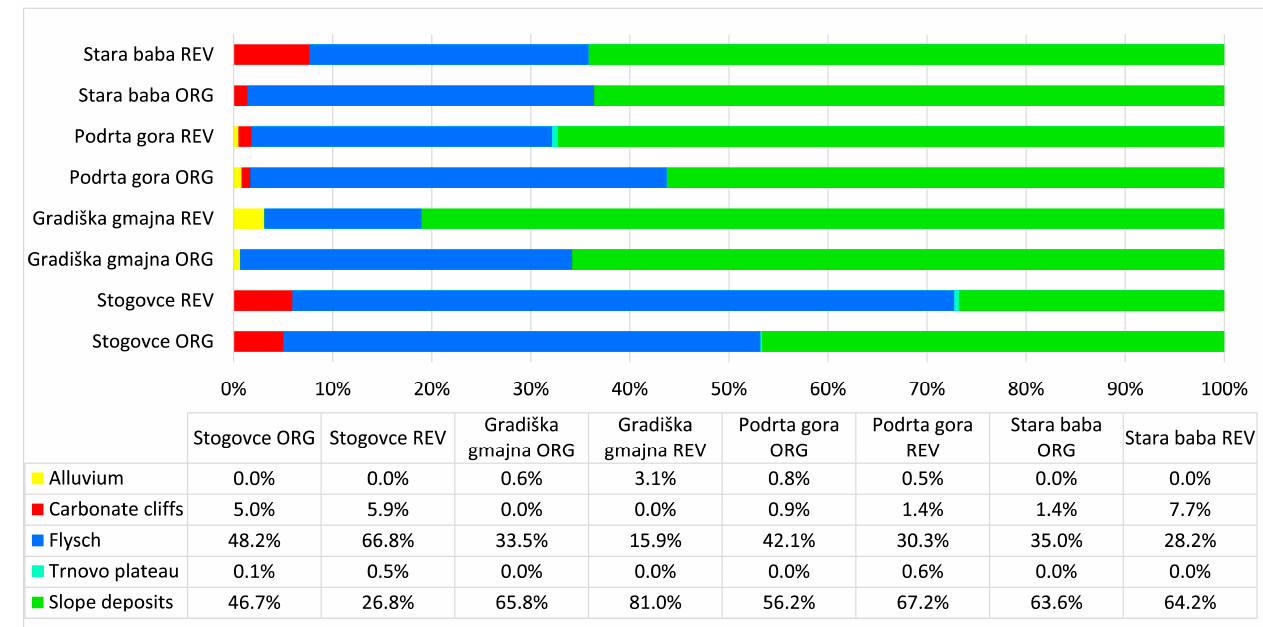
Figure 7. Bar chart comparison of the percentages of predicted units in the areas of landslides Stogovce, rock avalanches Podrta gora and Gradiška gmajna, and translational carbonate block Stara baba. ORG = original MLC method and REV = revised MLC method.